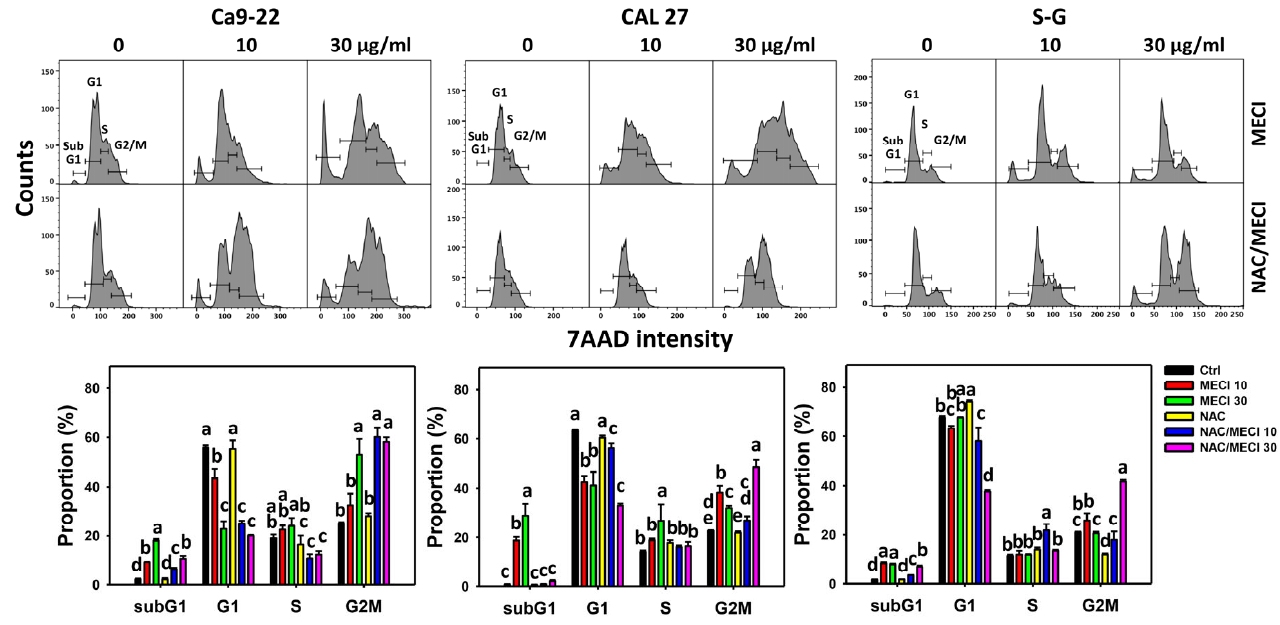
Figure 3. Cell cycle analysis. Except for S ‐ G cells, others were oral cancer cells. After pretreating with NAC, cells were post ‐ treated with MECI (0 (0.1% DMSO in the medium), 10, and 30 μ g/mL) for 24 h and applied to the flow cytometry. Data, mean ± SD ( n = 3). For the same cell line, columns showing non ‐ overlapping letters differ significantly ( p < 0.05).